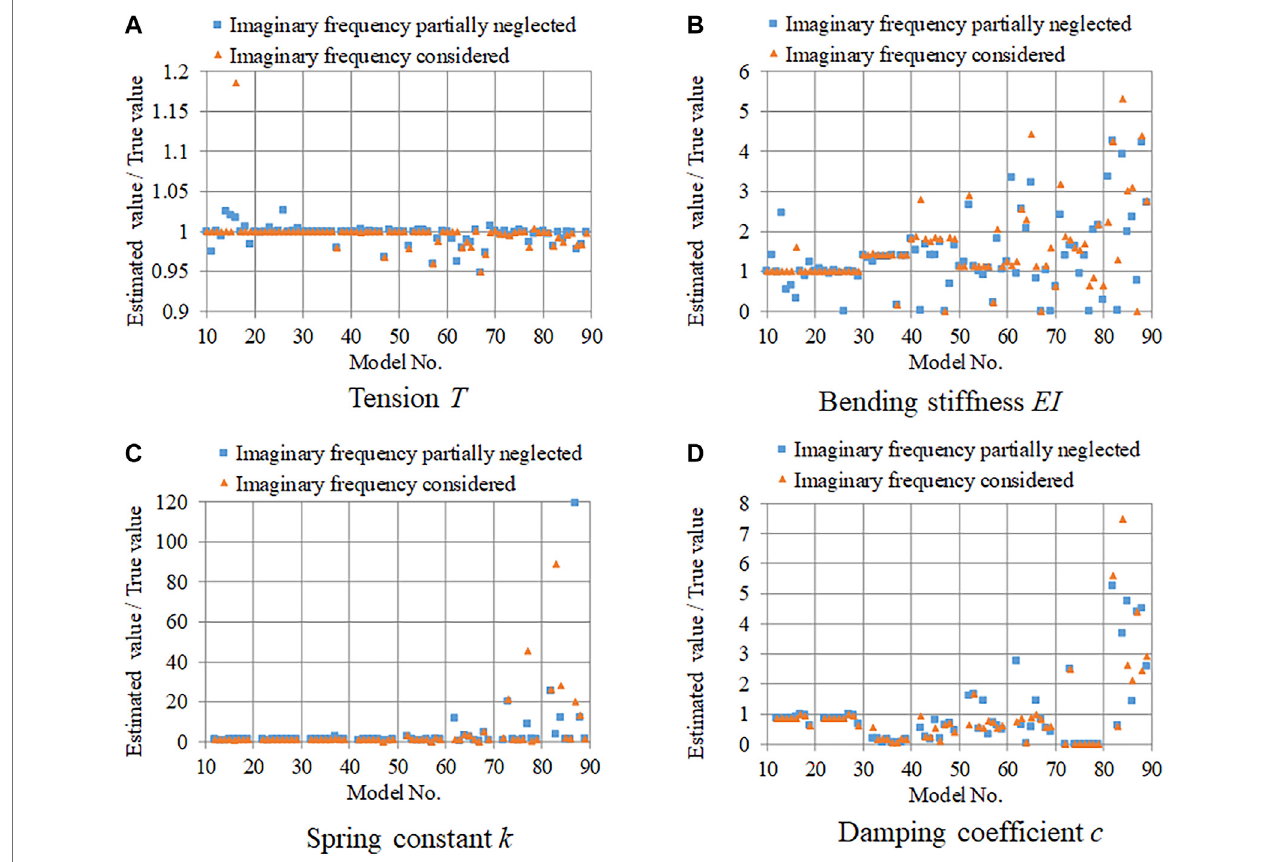
FIGURE 4 | Effect of partially ignoring imaginary part of complex natural frequency in viscous shear damper model: (A) tension; (B) bending stiffness; (C) spring constant; (D) damping coef fi cient.